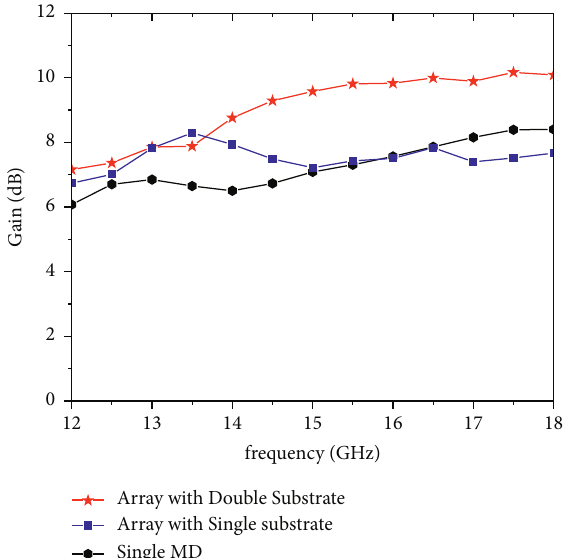
Figure 5: The antenna gain with the effect of the 2nd substrate.